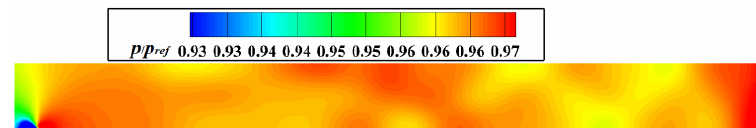
Figure 17. Pressure distribution in the port at 0.14 ms for the case of gap width of 0.8 mm, pressure ratio of 1.5.